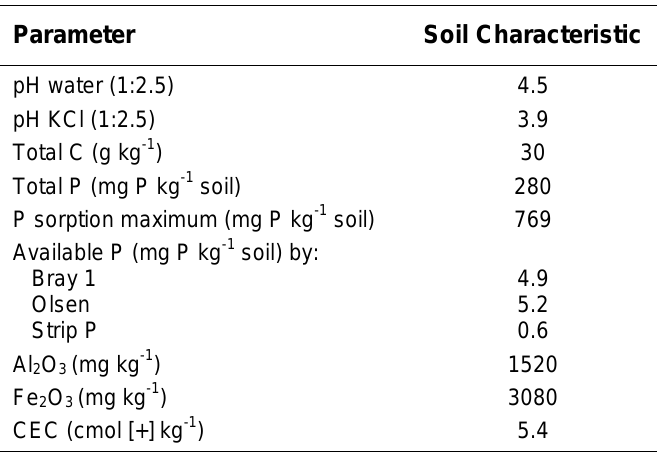
Characteristics of the Top- and